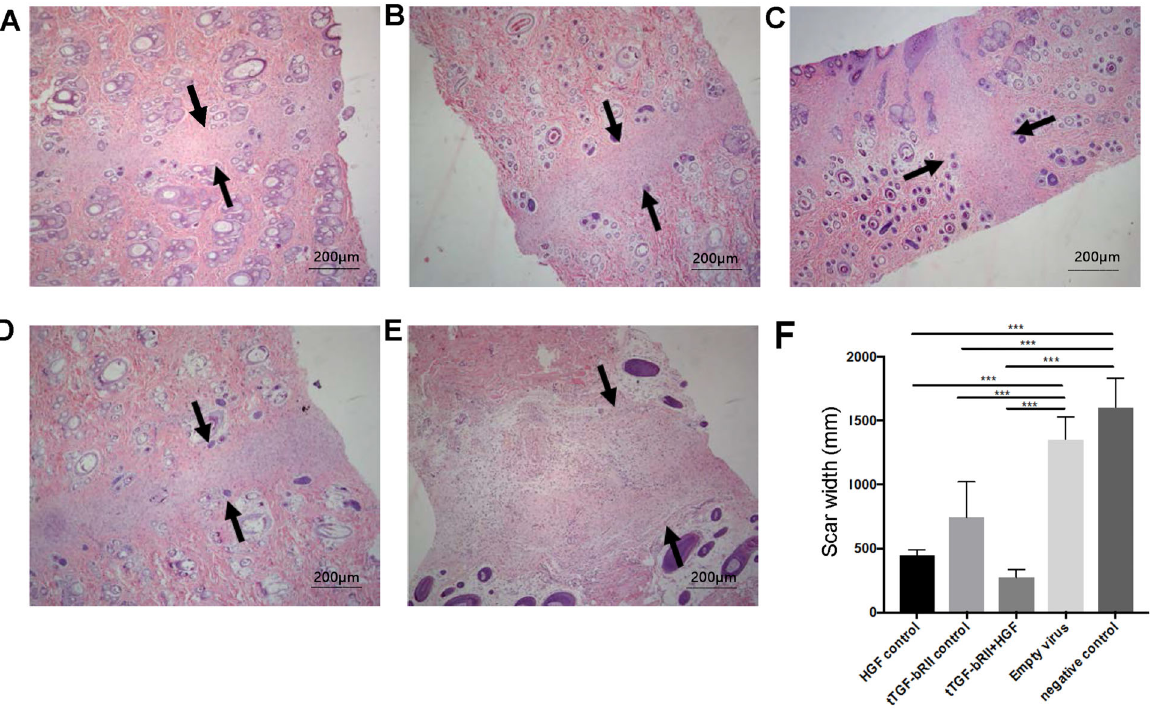
Figure 3. Scar width in each group. Histological examination revealed that the width of the scar was narrower in the experimental wound (hematoxylin and eosin staining; original magni fi cation: (cid:1) 100, bars: 200 m m). Arrows indicate the scar width. A , Experimental group (t-TGF- b RII + HGF); B : t-TGF- b RII group; C : HGF group; D : empty virus group; E : blank group. F , Summary of scar width. Data are reported as means ± SD. ***P o 0.001 (Student-Newman-Keuls test). t-TGF- b RII: truncated transforming growth factor- b type II receptor; HGF: hepatocyte growth factor.